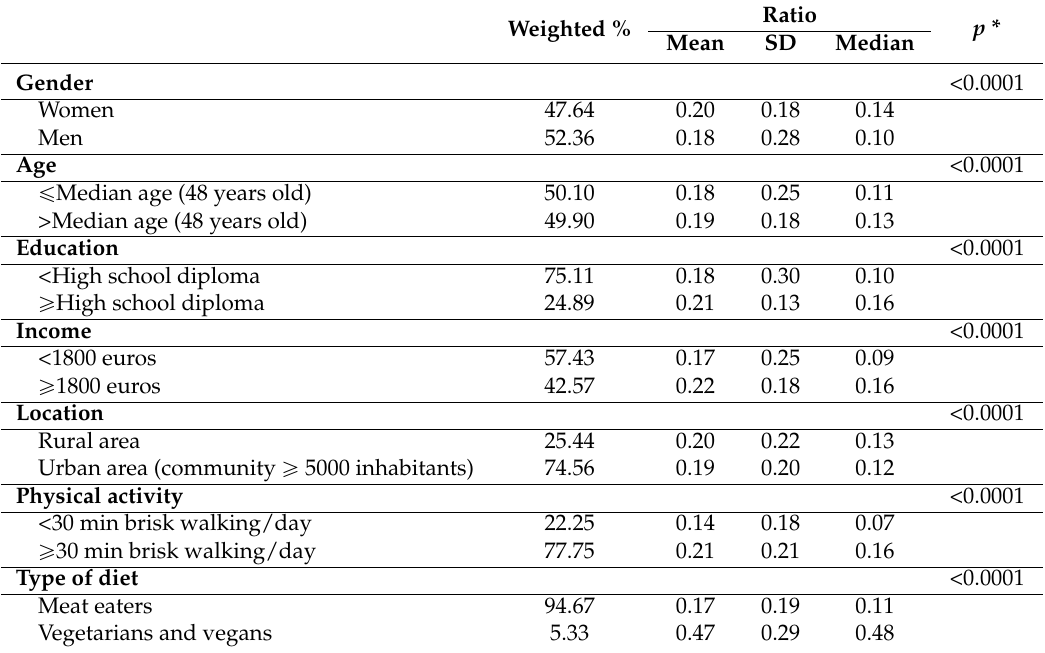
Table 5. Share of organic food in the whole diet according to several sociodemographic and lifestyle factors, NutriNet-Santé Study, N =